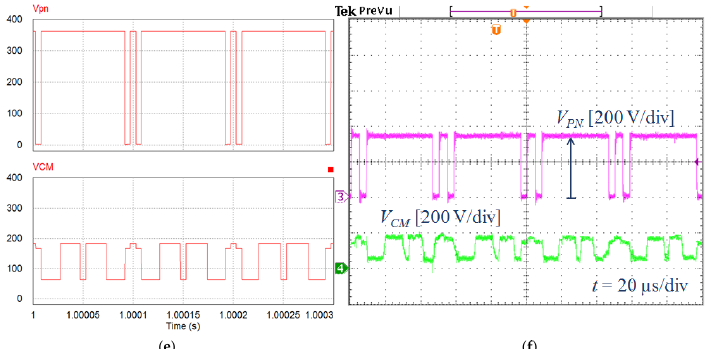
Figure 11. MAqZSI under the proposed CMV-SVM reduction method when V i = 250 V, D = 0.11. ( a , c , e ) Simulation results and ( b , d , f ) experimental results. From top to bottom: input voltage, output currents, capacitor C 1 voltage, v ab voltage, DC-link voltage, and CMV.